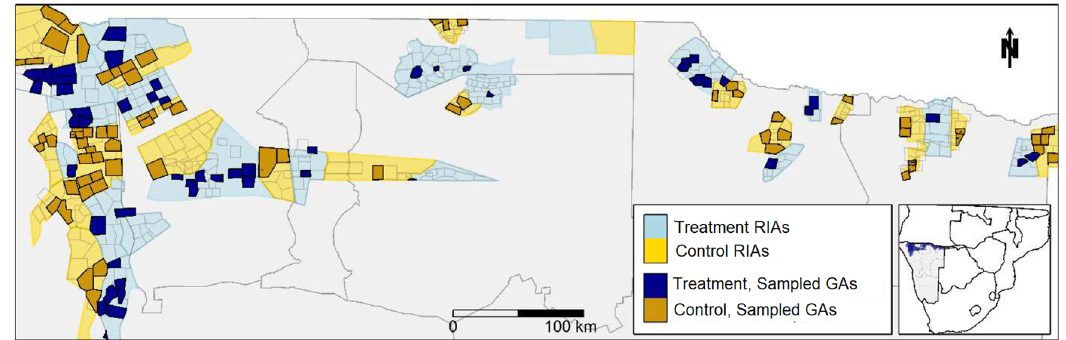
Fig. 1 Distribution of rangeland intervention areas (RIAs) and grazing areas (GAs) for CBRLM in northern Namibia. Blue and yellow colors identify treatment and control RIAs, respectively. Darker shading identi fi es the GAs that were sampled